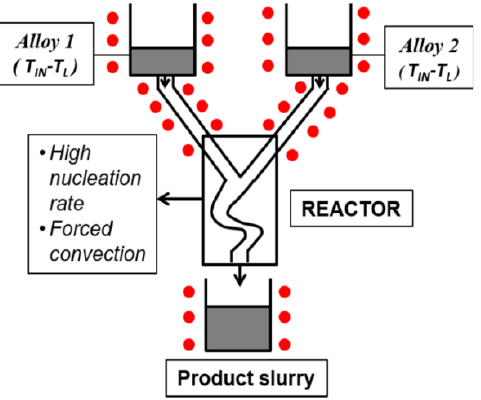
Figure 9. Schematic illustration of the continuous rheoconversion process (CRP) [123].